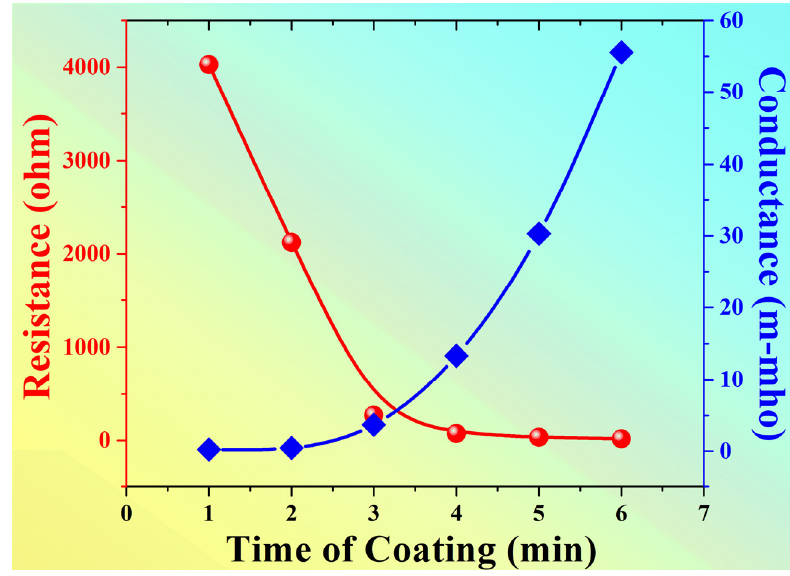
Figure 8. Relationship between Resistance and Conductance of the Coatings.